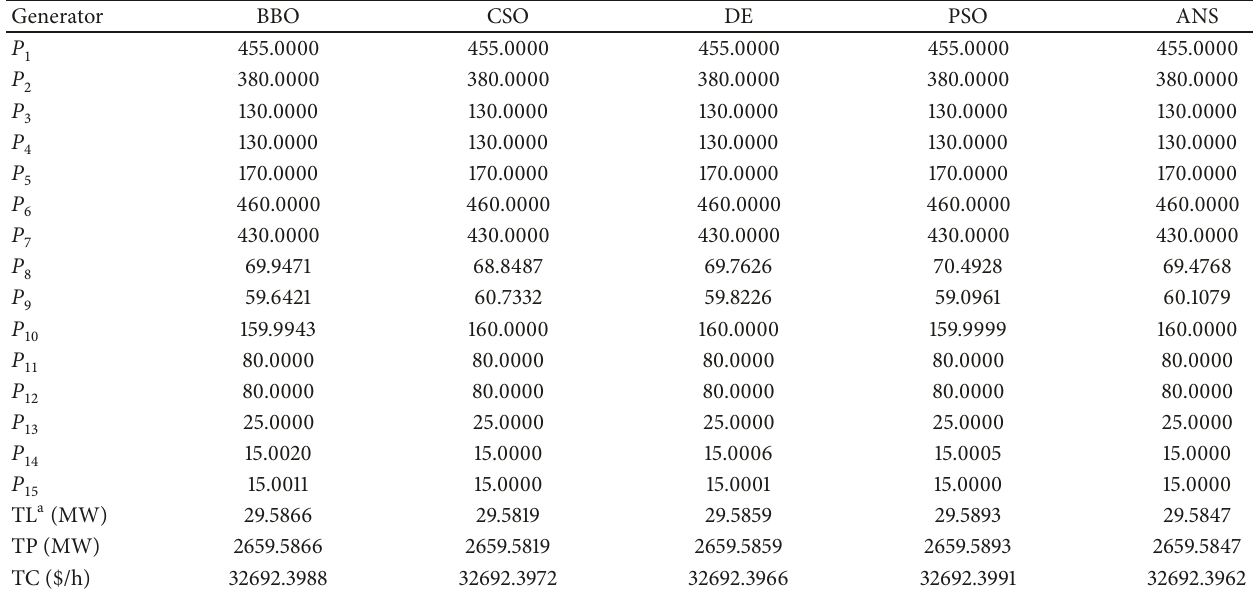
Table 7: Best output power for 15-generator system (Case